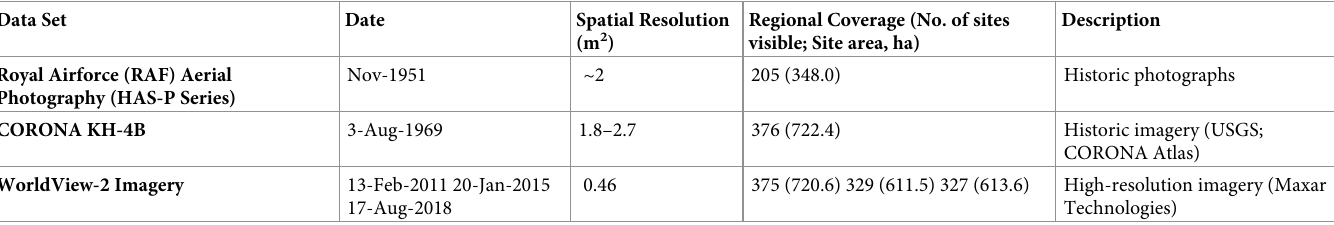
Table 1. The satellite imagery and historic aerial photographs used to assess archaeological sites in this study. Data Set Spatial Resolution